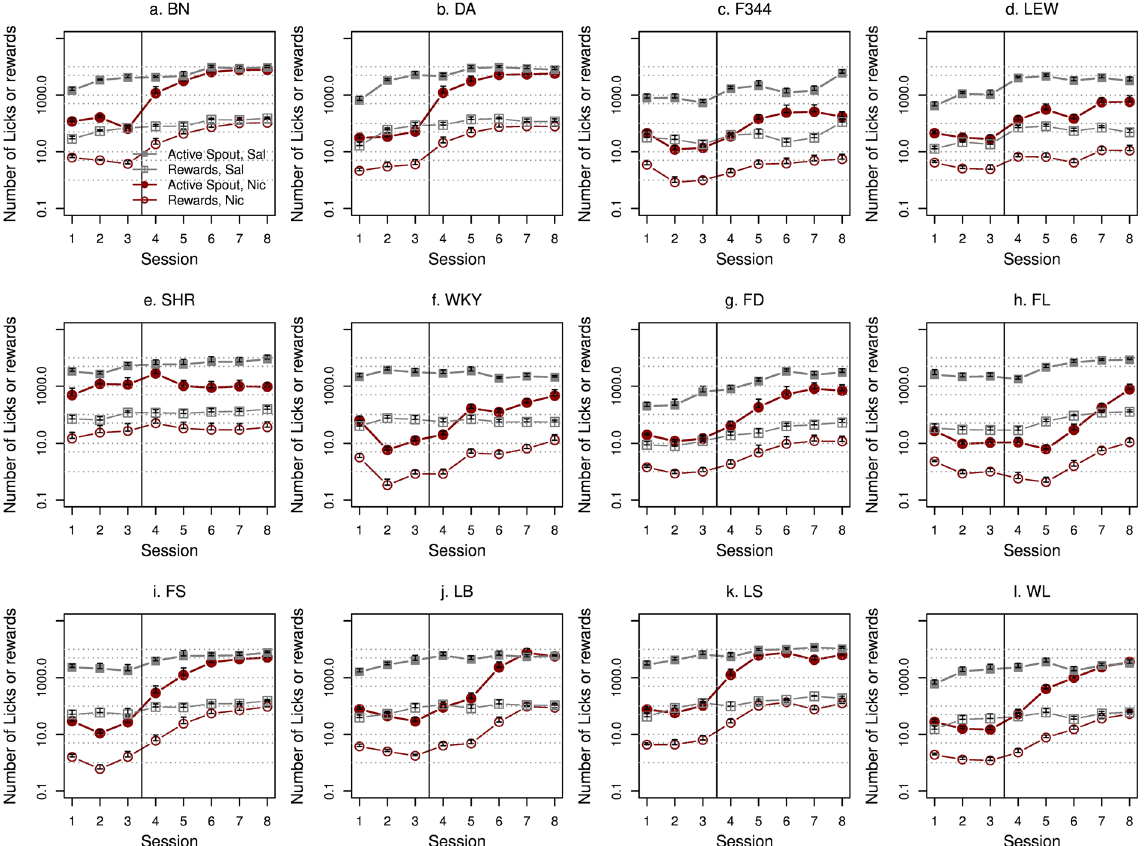
Figure 5. Nicotine CFA and extinction of CFA. Twelve isogenic strains of adolescent rats self-ministered nicotine (30 μ g/kg/inf, i.v.) with an appetitive flavor cue for three daily sessions without demonstrator rats (sessions 1–3). This was followed by five daily extinction sessions (sessions 4–8) where nicotine was not provided. Control rats received i.v. saline.